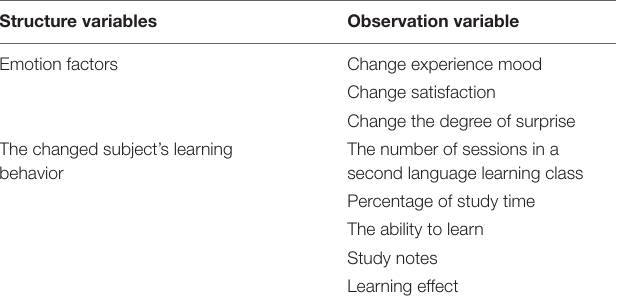
Frontiers in Psychology |